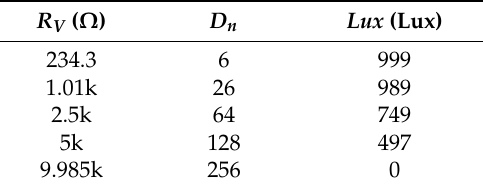
Figure 11. When Lux is 989 Lux, D n is 26. Table 3. R V , D n and Lux .